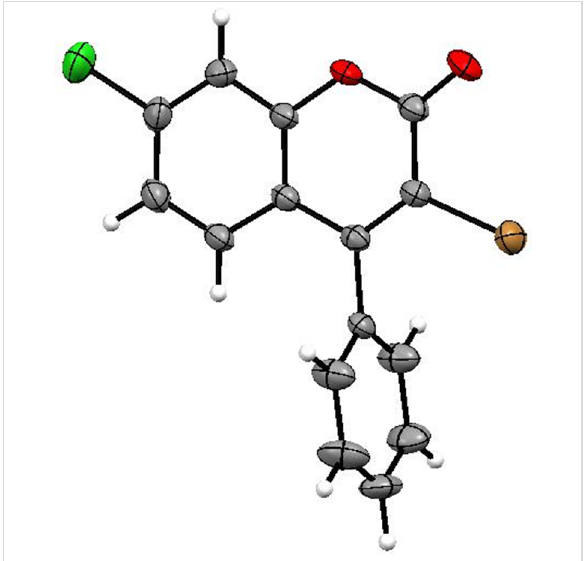
Figure 1: ORTEP of 3-bromo-7-chloro-4-phenylcoumarin ( 3Da ).